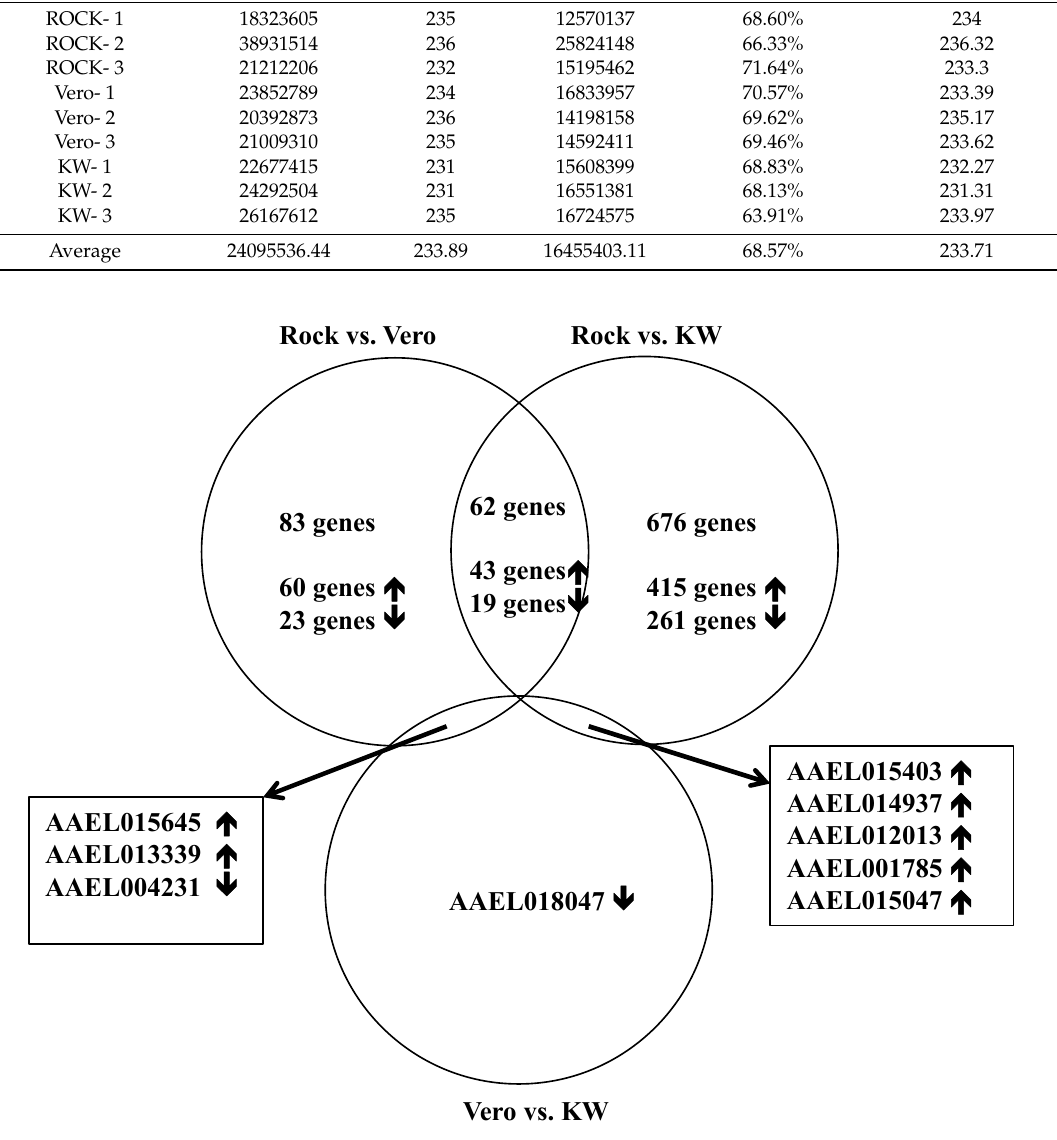
Figure 1. Venn diagram comparing di ff erentially expressed genes among three-paired comparisons from three populations.